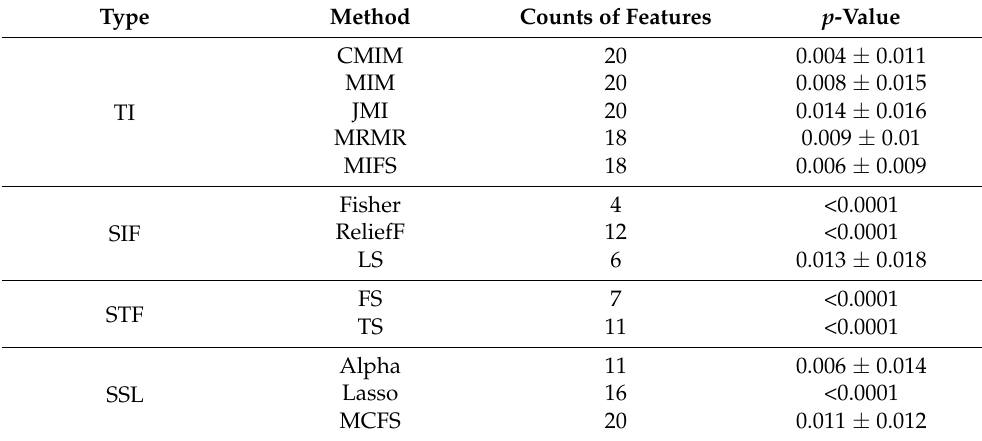
Table 6. Statistics of extracted features from the 13